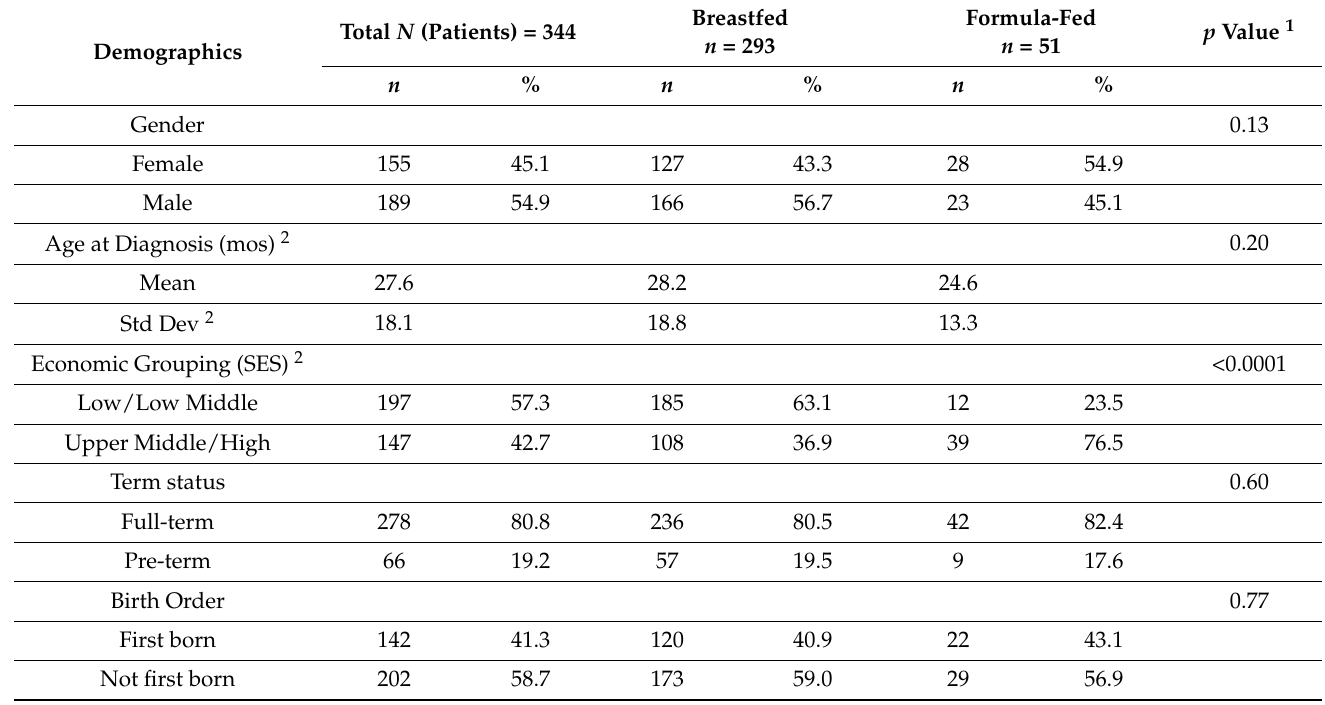
Table 1. Distribution of demographics and breastfeeding